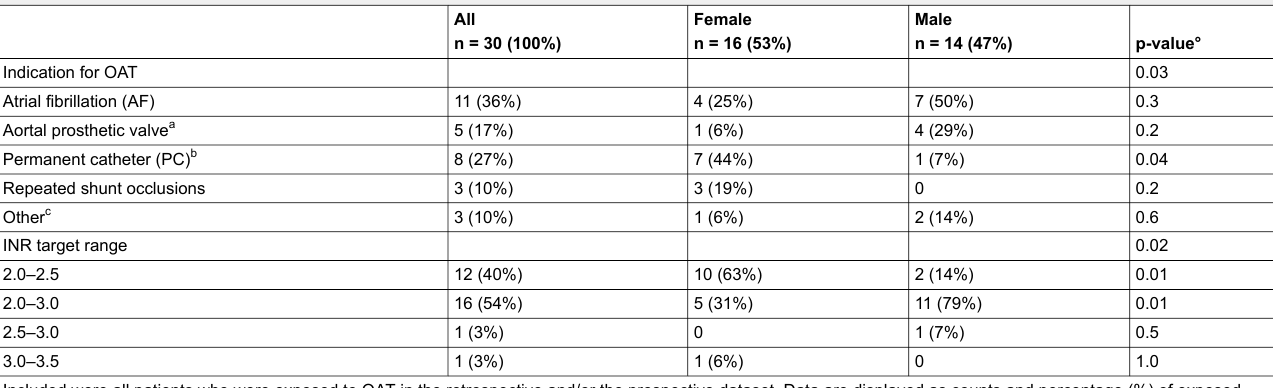
Table 1: Indication for oral anticoagulation therapy (OAT) and INR target range overall and by gender.